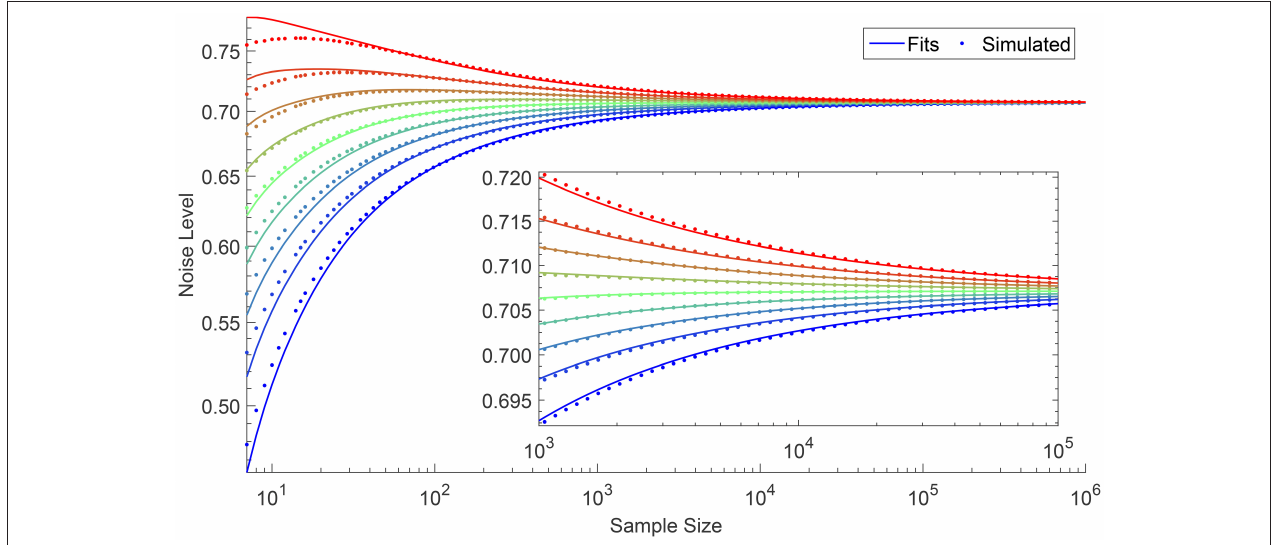
FIGURE 6 | Relationship between distribution noise d DN and sample size N at deciles going from the 10th percentile (blue) to the 90th (red), obtained from 10 6 simulations. The d DN value converges to 1 / √ 2 as N